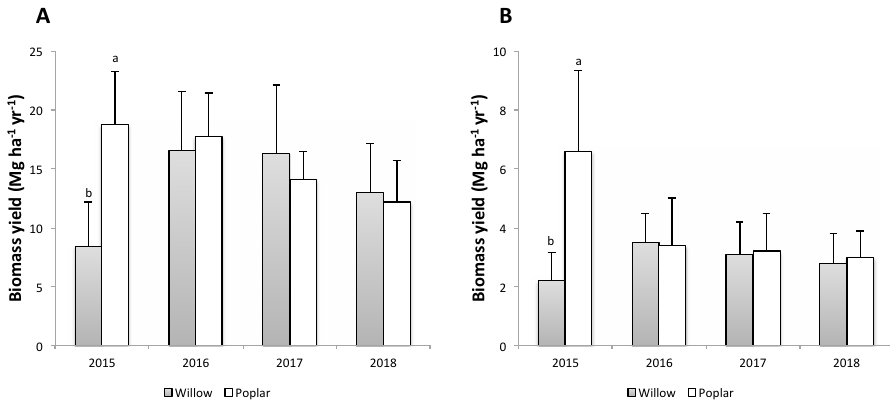
Figure 1. Willow and poplar woody ( A ) and leaf ( B ) biomass yields for the four years of the trial. Values are mean ± SD (n = 20) for each species. A 5% significance level was adopted for identifying significant treatment effects according to Tukey’s HSD test. Different letters on bars denote a significant difference among species.